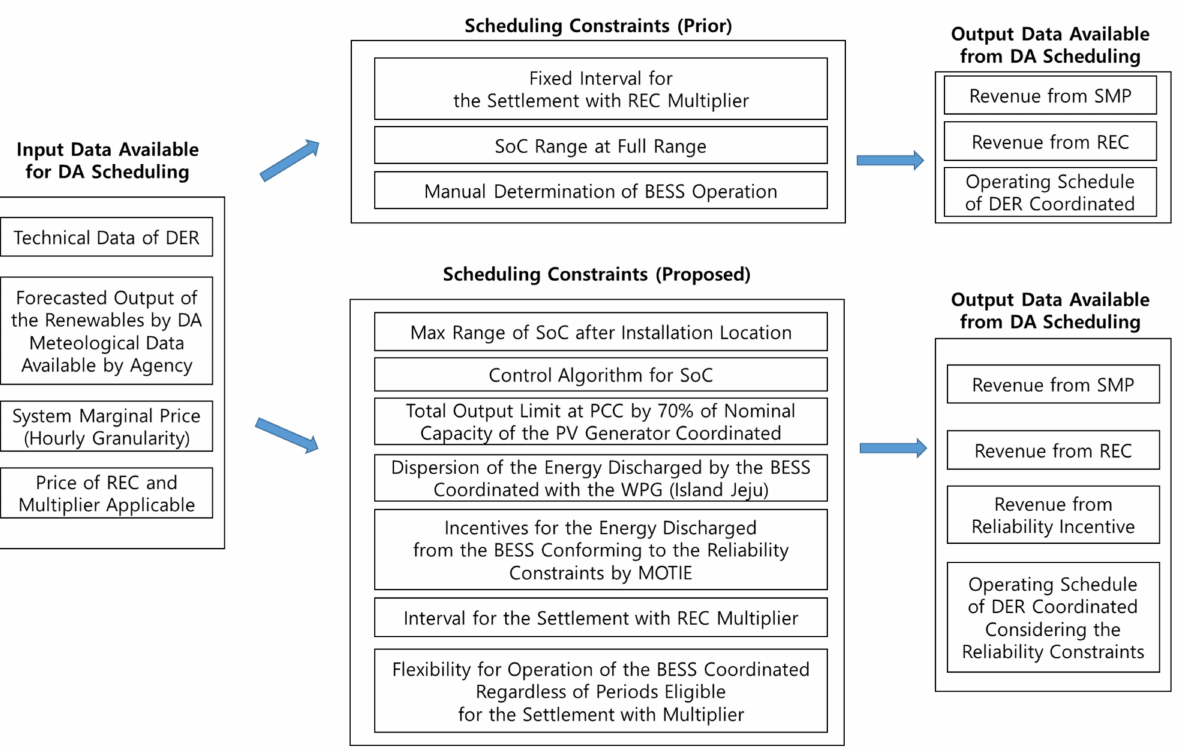
Figure 2. Comparison between the prior scheduling methods and the scheduling method